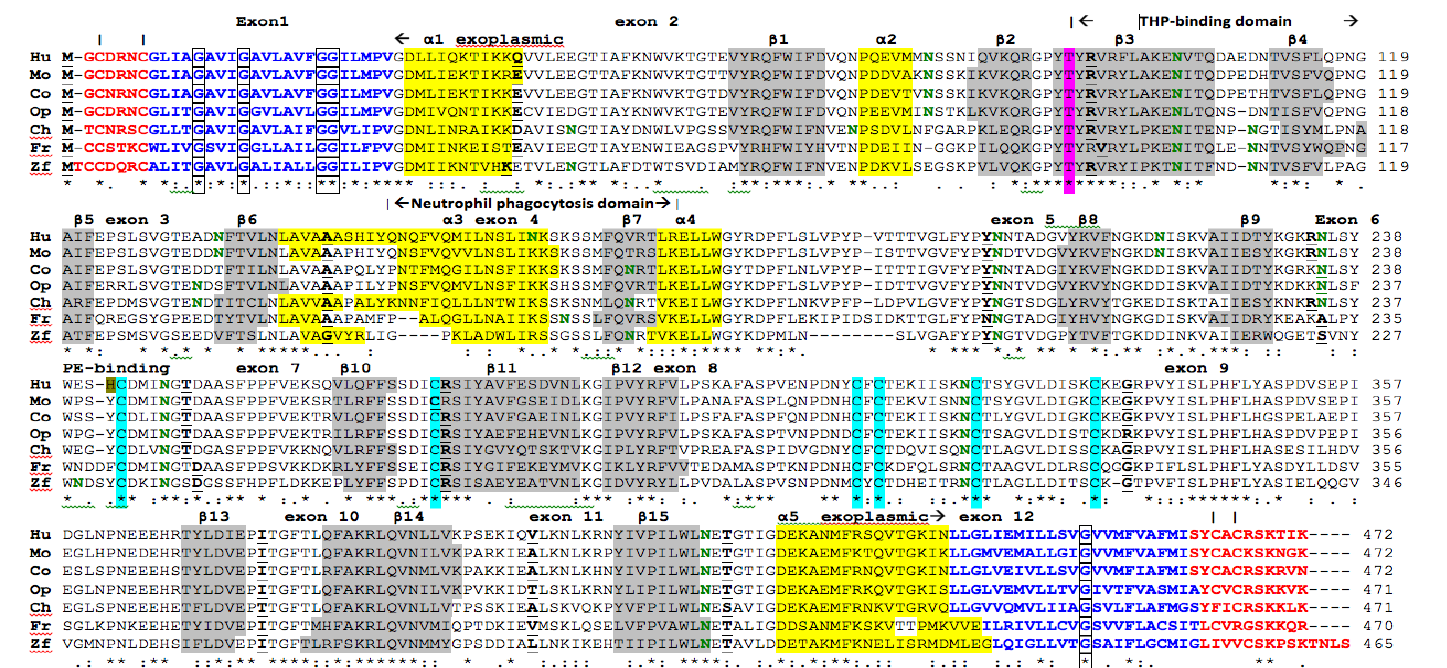
Figure 1. Amino Acid Sequence Alignments for Vertebrate CD36 Sequences. See Table 1 for sources of CD36 sequences; Hu-human; Mo-mouse; Co-cow; Op-opossum; Ch-chicken; Fr-frog; Zf-zebrafish; * shows identical residues for CD36 subunits; : similar alternate residues; . dissimilar alternate residues; predicted cytoplasmic residues are shown in red; predicted transmembrane residues are shown in blue; N -glycosylated and potential N -glycosylated Asn sites are in green ; exoplasmic Thr92, which is phosphorylated by pyruvate kinase alpha, is shown in pink; predicted disulfide bond Cys residues are shown in blue; predicted α-helices for vertebrate CD36 are in shaded yellow and numbered in sequence from the start of the predicted exoplasmic domain; predicted β-sheets are in shaded grey and also numbered in sequence; bold underlined font shows residues corresponding to known or predicted exon start sites; exon numbers refer to human CD36 gene exons; G residues refer to conserved glycines in the N - and C -terminal oligomerisation domains of the trans-membrane sequence [49]; CD36 binding domains are identified: THP-refers to binding region for low-density lipoproteins [6–8]; neutrophil phagocytosis domain designated by [3,7]; PE binding refers to cytoadherence region of Plasmodium falciparum -parasitized erythrocytes (PE) to endothelial cells